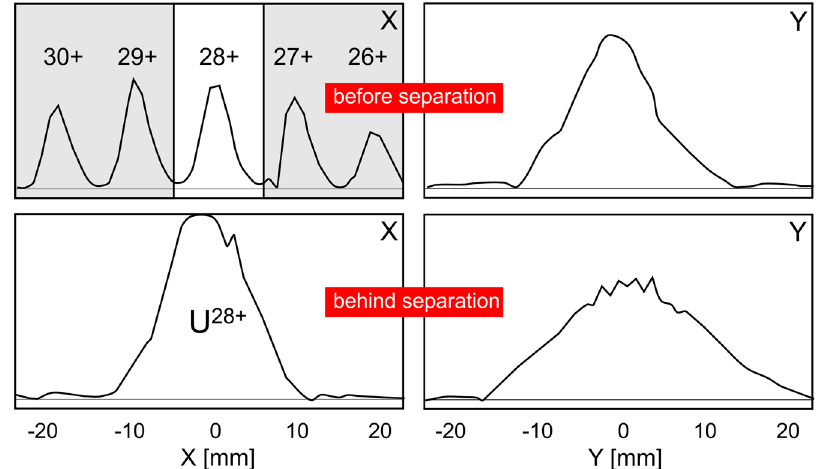
FIG. 7. High current uranium beam profile directly before and 150 cm behind separation slit applying H 2 -gas cell; position of the charge separating slit is shown in grey. The desired charge state 28 þ is purely separated from the neighboring charge states.